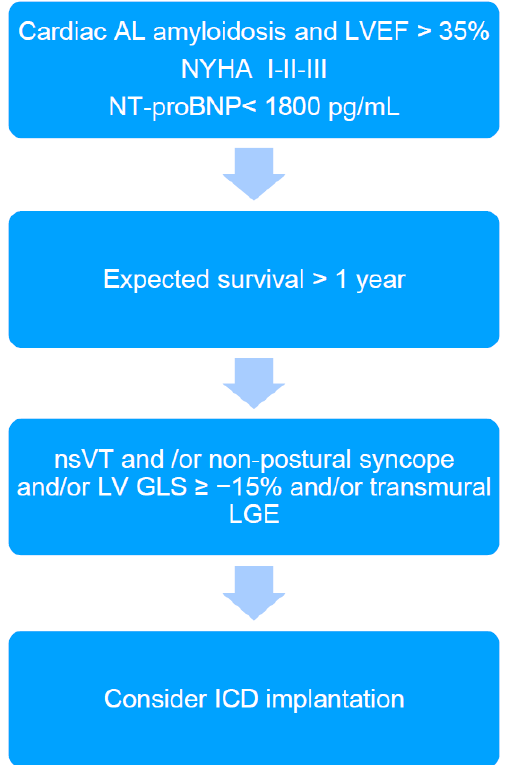
Figure 2. The algorithm proposed for qualifying cardiac immunoglobulin-derived light chains amyloidosis (AL) patients for ICD implantation in primary prevention of sudden cardiac death (2). ICD: implantable cardioverter-defibrillator; LVEF: left ventricular ejection fraction; NT-proBNP: N-terminal pro brain natriuretic peptide; nsVT: non-sustained ventricular tachycardia; LV GLS: left ventricular global longitudinal strain; LGE: late gadolinium enhancement.